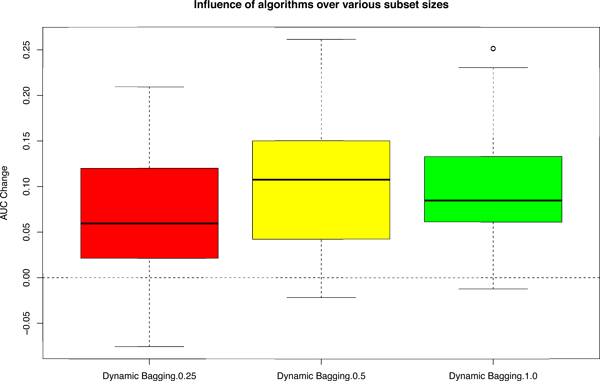
Boxplot of AUC change on varying subset sizes under various scenarios (36) for data set A, D and F. AUC Change = AUCafter - AUCbefore. Subset size here implies using a random subset of the given data during training phase. "Dynamic Bagging.0.25", "Dynamic Bagging.0.5" and "Dynamic Bagging.1.0" are the AUC change after applying dynamic bagging and using rank values with 25%, 50% and 100% of the original given data for training respectively compared with the conventional approach, which is without bagging and using absolute values [9].